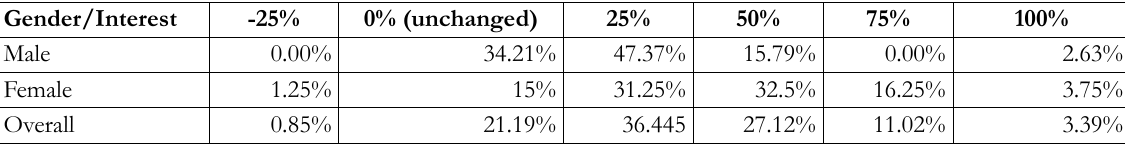
Table 3. Percentage Increment on Interest Level of Students in Engineering After the Program According to Gender